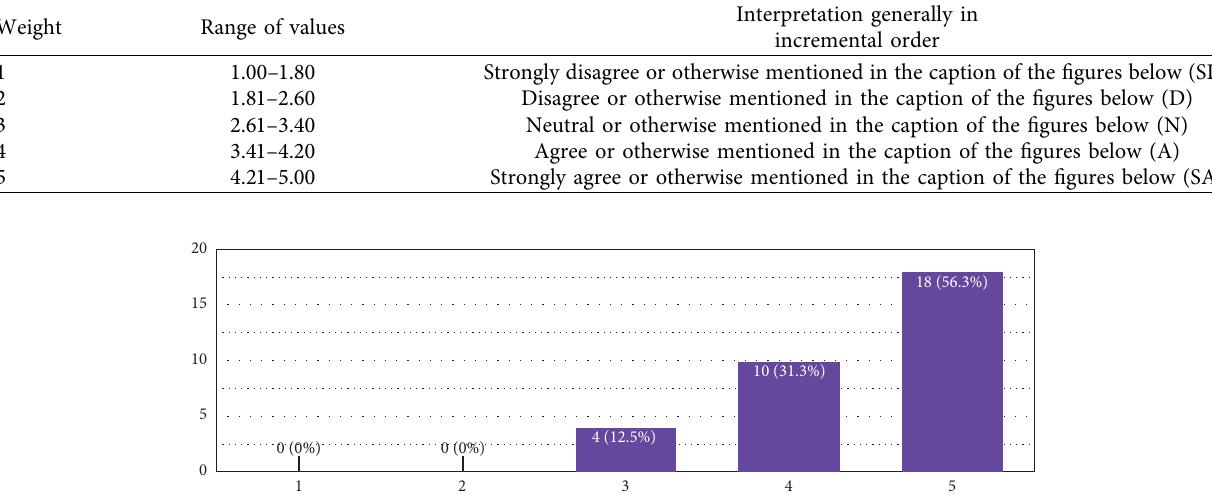
Figure 2: In the X -axis, 1 is to be read as “not great for learning,” 5 is to be read as “very good idea for learning,” and the remaining are the extrapolations in the middle as per the Likert scale. Te Y -axis is the number of responses.